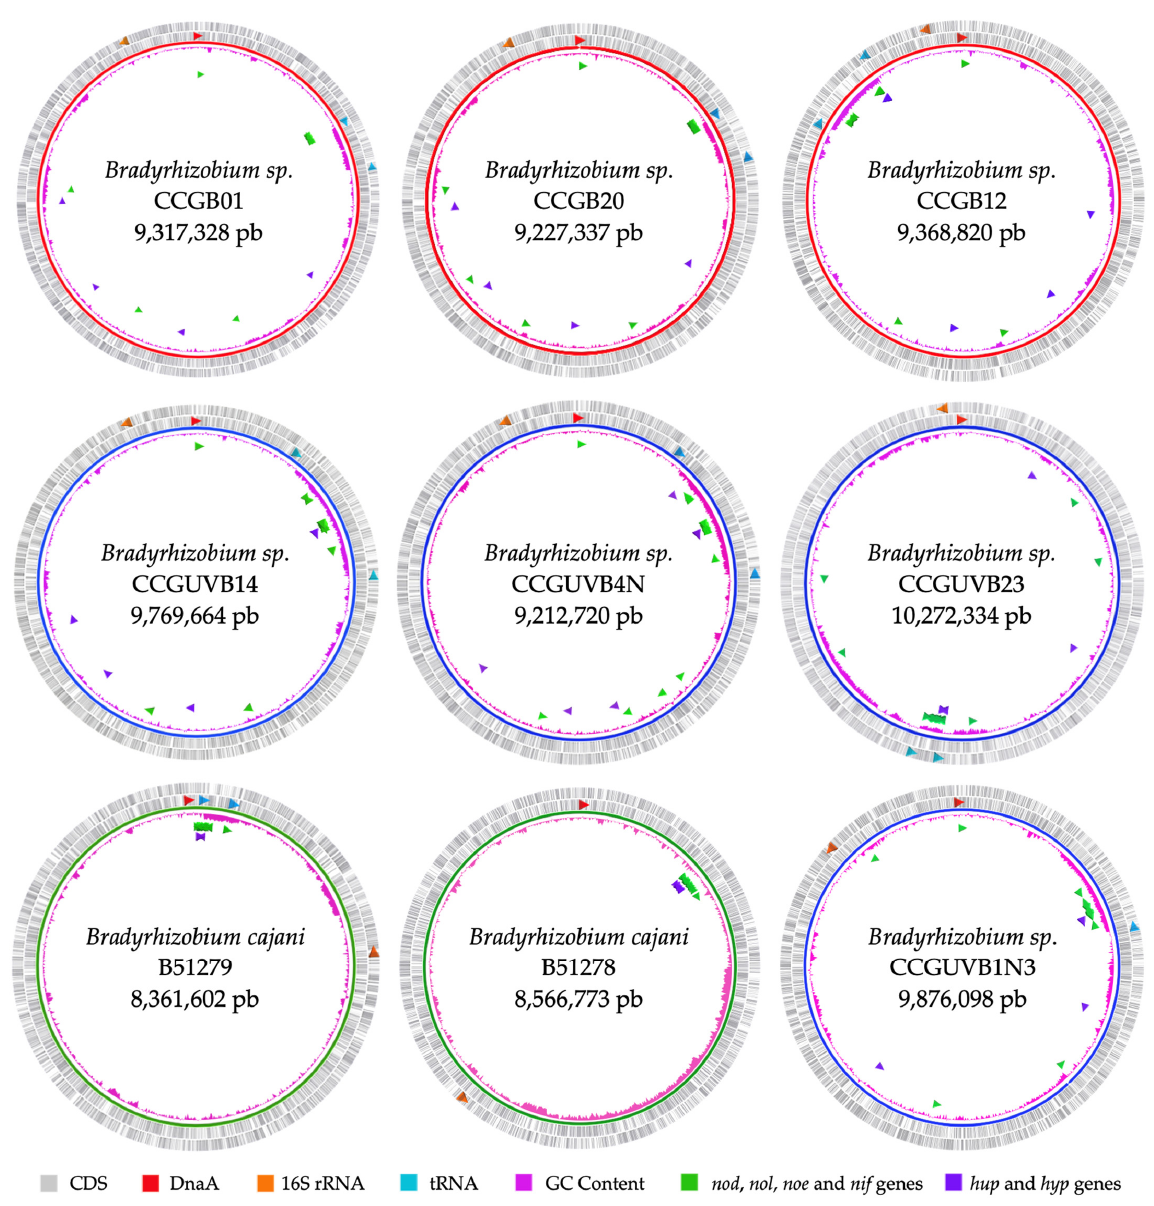
Figure 5. Circular representation of the chromosome of the Lysiloma spp. and Inga vera Bradyrhizobium isolates. The rings from outside to inside indicate: (1) the chromosome and the coding sequences (CDS); (2) the genome sequence in blue color for Inga vera isolates, red for Lysiloma sp. isolates, green for L. divaricatum isolates; (3) the GC percentage across the chromosome; (4) the nod, nol, noe and nif genes predicted with EggNogg Mapper; (5) the hup and hyp genes predicted with EggNogg Mapper. The name of the strain and its genome size are indicated in the center of the circle. The probable symbiotic islands are flanked by a t-RNA, highlighted in the outermost ring.